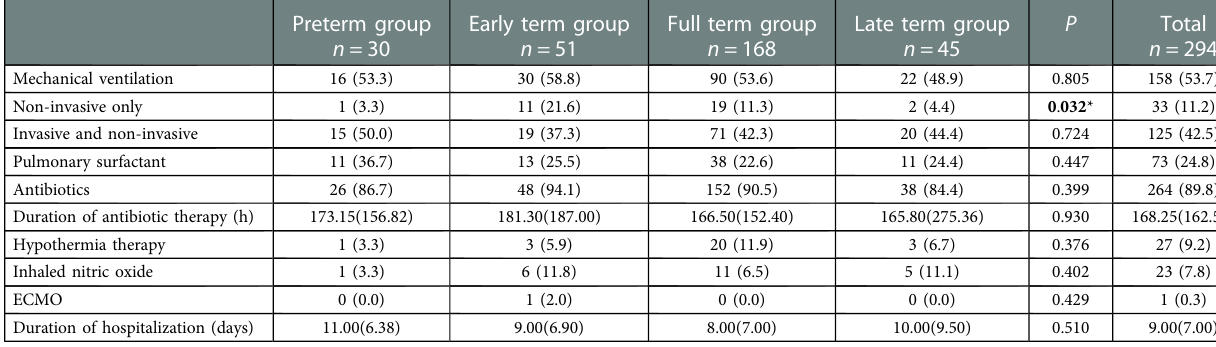
TABLE 3 Comparison of treatment of patients with different gestational age [ n (%) or median (IQR)].